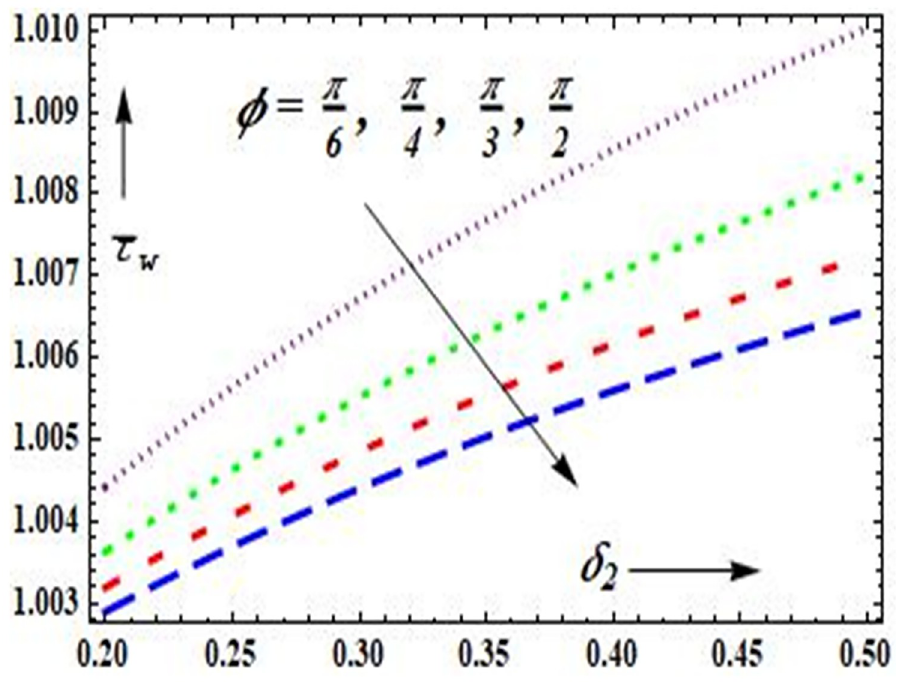
Fig 15. Plot of � τ on ϕ & δ 2 with M = 0.2, d 1 = 0.2, F = 0.3, d 2 = 0.6, L 2 = L 1 = 0.2, r = 2.0, Q = 0.1. w